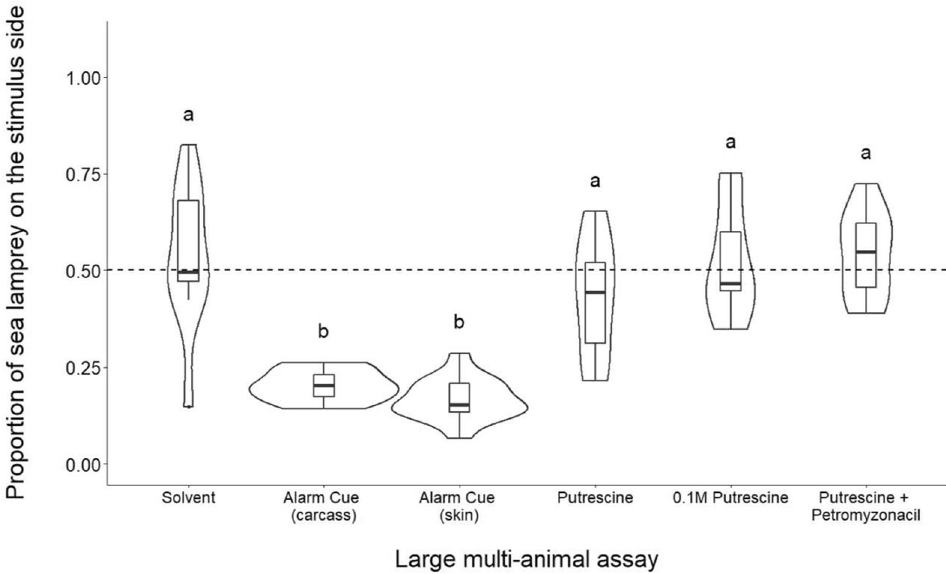
Figure 4. Boxplots representing the proportion of sea lamprey on the stimulus side after the addition of odorants. The middle quartile of boxes represents treatment median, and upper and lower quartiles are the 75th and 25th percentile of the range, respectively. Upper and lower whiskers represent the minimum and maximum spread of the data. Violin plots demonstrate the frequency of proportion values for each treatment. Dashed line at 0.50 represents the null hypothesis of a true neutral response to introduced stimulus. Treatments with different letters are significantly different from one another based on Dunn’s test ( α = 0.05). N = 15 for crude skin alarm cue treatment. N = 10 for solvent, full body alarm cue, putrescine, and putrescine + petromyzonacil treatments. N = 5 for 10 –1 M putrescine